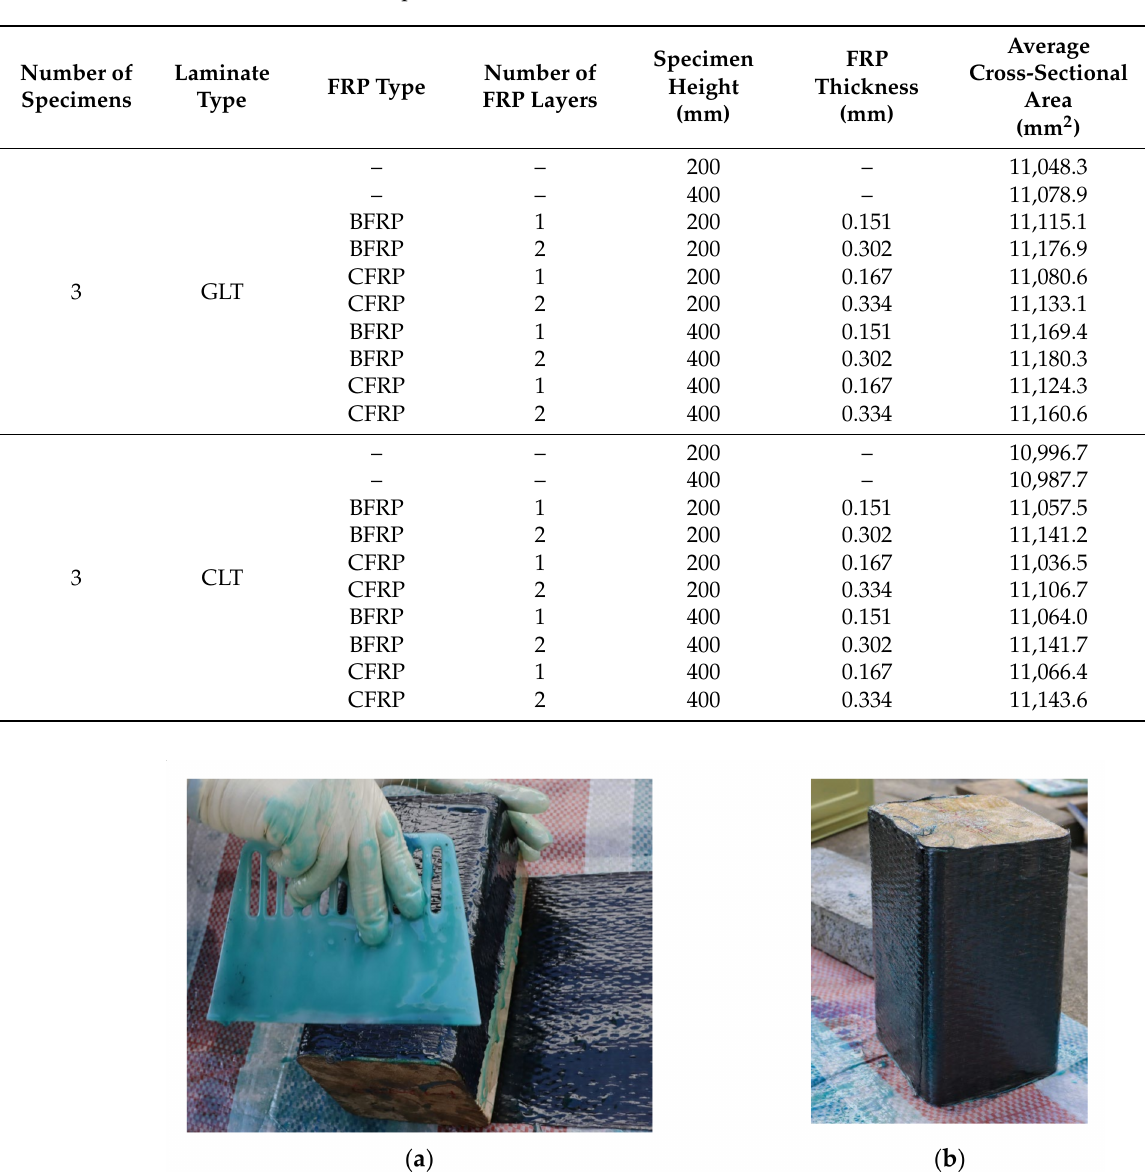
Table 2. Details of test specimens.